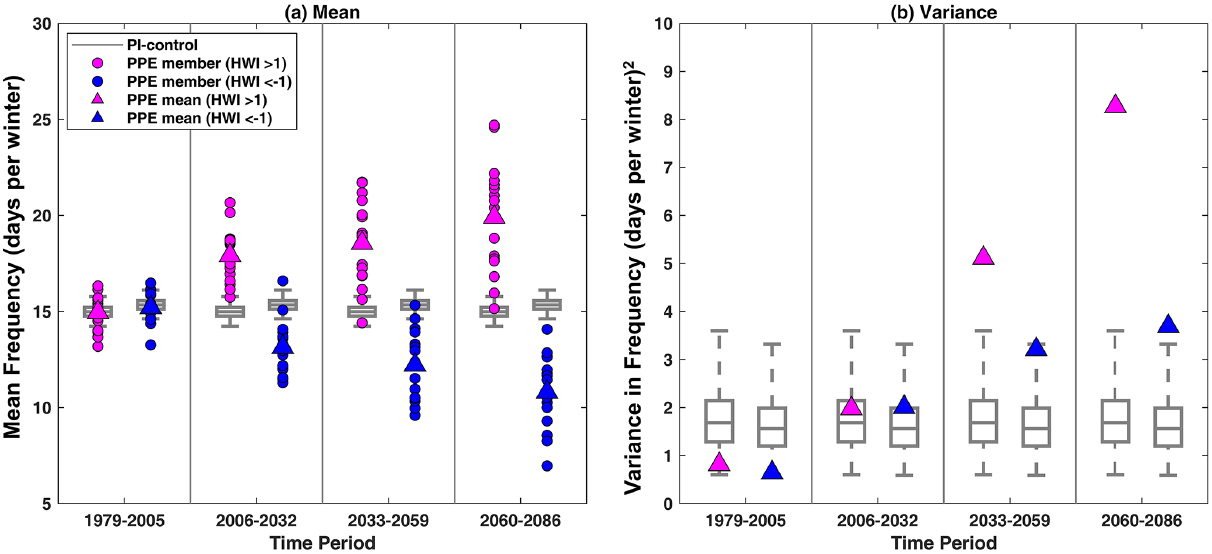
Figure 6. (a) Mean frequencies of haze-conducive weather (HWI > 1, pink) and clear weather (HWI < − 1, blue) for the historical period (1979–2005) and for the near (2006–2032), mid- (2033–2059), and far (2060–2086) future under the RCP8.5 scenario. Circles represent PPE members and triangles show the PPE mean. Grey boxes and whiskers show the distributions of 10000 mean frequency values sub- sampled from the control simulation. Panel (b) is the same as (a) but it shows the variance across the 16 PPE members for each period. For each box and whiskers, we first randomly sampled 10000 time series, each of length 27 years, using 2704 years of pre-industrial control simulation and calculated 10000 values of mean frequency. We then randomly sub-sampled 16 mean values (corresponding to the number of ensemble members) from the 10000 mean values and calculated their mean (a) and variance (b) . This was repeated 10000 times to obtain a distribution. The boxes are at the 25th and 75th percentiles and the whiskers are at the 2.5th and 97.5th percentiles of the mean and variance distributions. For panel (a) , the box and whiskers are comparable only for the ensemble means (triangles) and not the ensemble members